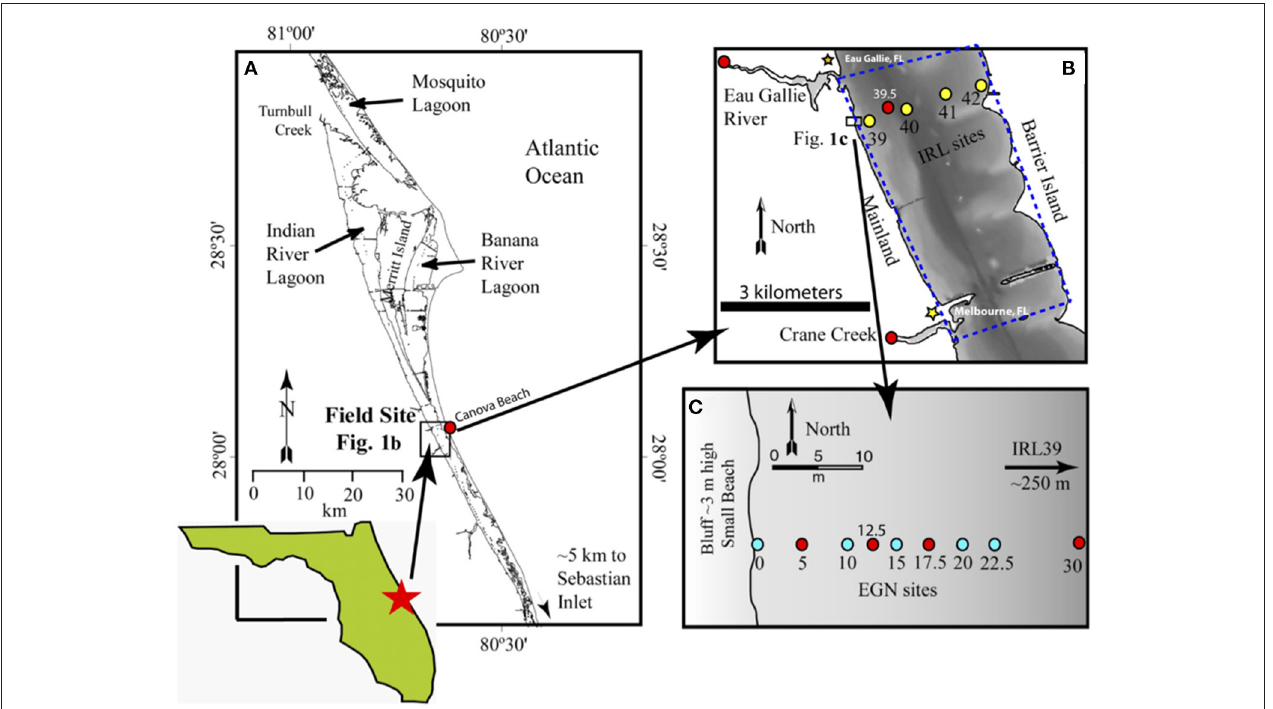
FIGURE 1 | Location of the field site along the Atlantic coast of Florida. (A) Shows the general location of the portion of the Indian River Lagoon studied as well as the location of the Canova Beach sample. (B) Documents the studied portion (blue dashed polygon) of the Indian River Lagoon and the offshore “CIRL-x” transect (yellow circles), and (C) illustrates the nearshore “EGN-x” transect in which the colored, numbered circles depict the location of each multi-level piezometers [multisamplers of Martin et al. (2003)] where groundwaters and surface lagoon waters were sampled and analyzed for REEs and Nd isotope compositions. Note, the blue circles on (C) depict samples for which only REE concentrations were determined, whereas the red circles indicate locations where REE concentrations and Nd isotope compositions were measured. (B) Also shows location where the Eau Gallie River and Crane Creek samples were collected (see Johannesson et al., 2011), the location where the Indian River Lagoon surface water Nd isotope sample was collected (i.e., CIRL 39.5), and the location of the multi-level piezometer CIRL-39 at 39, and the Lee-type seepage meters at 39, 40, 41, and 42 installed across the width of the Indian River Lagoon. Sample locations shown as red circles on (A,B) also indicate locations where we collected samples for ε Nd (0)